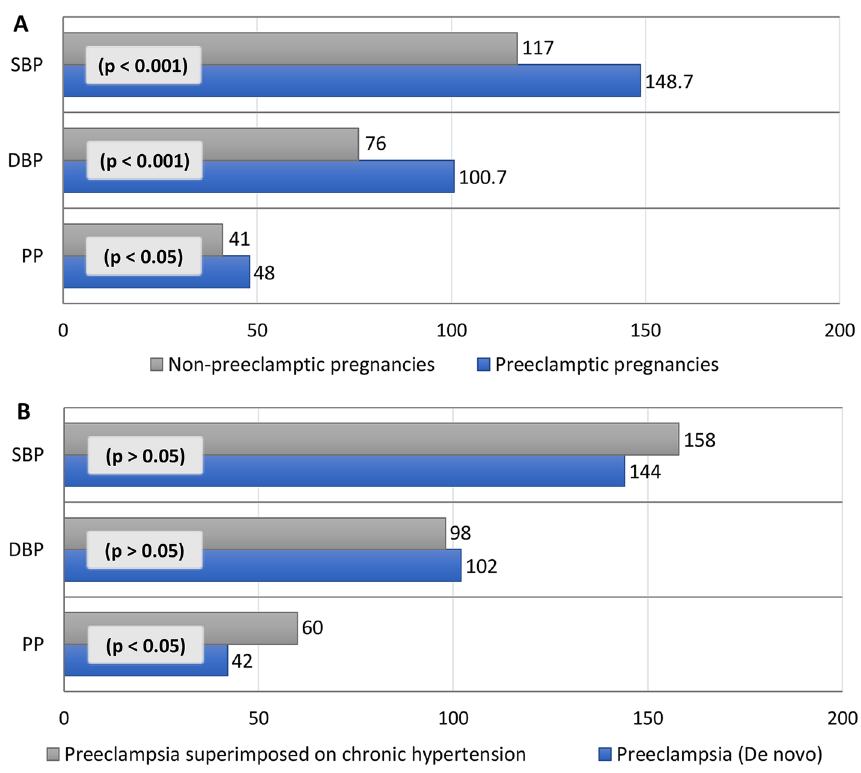
Figure 1. Blood pressure components in preeclamptic and non-preeclamptic pregnancies ( A ); Blood pressure components in pregnancies with preeclampsia and preeclampsia superimposed on chronic hypertension ( B ). Data are presented as mean. SBP systolic blood pressure, DBP diastolic blood pressure; PP pulse pressure (SBP − DBP). P-values are obtained from independent sample t-test in comparison between two groups. De novo: preeclampsia with hypertension developed after 20 weeks of gestation.